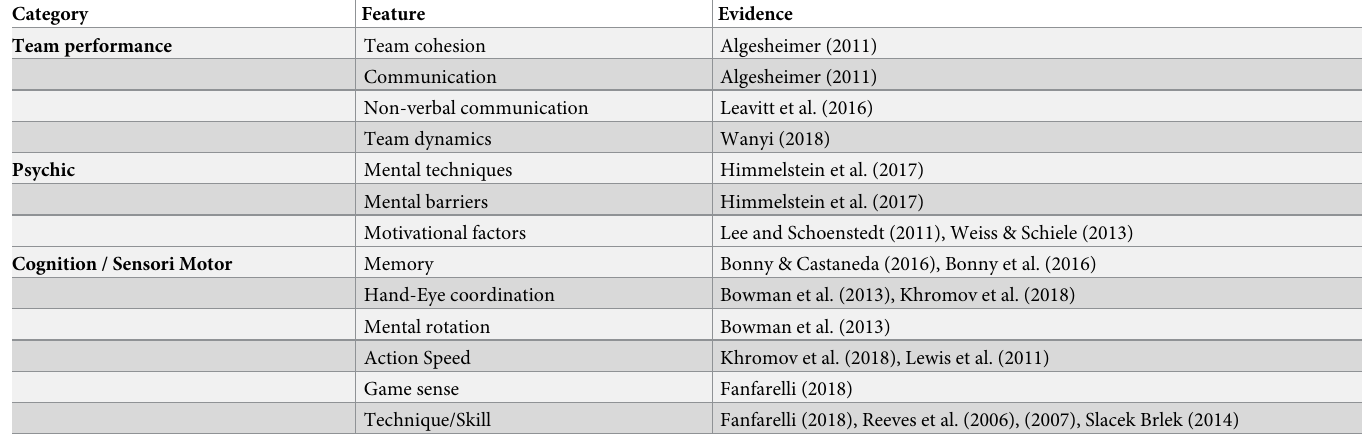
Table 4. Studies addressing selected components of esports